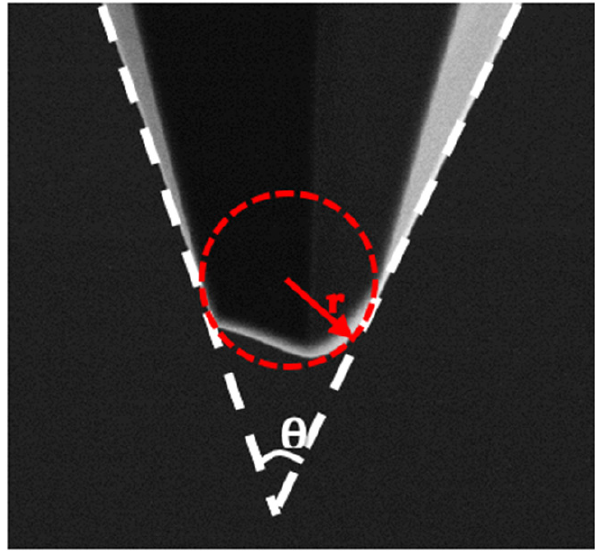
Figure 4. Tip radius r and opening angle θ define the geometry of the pyramidal tip.